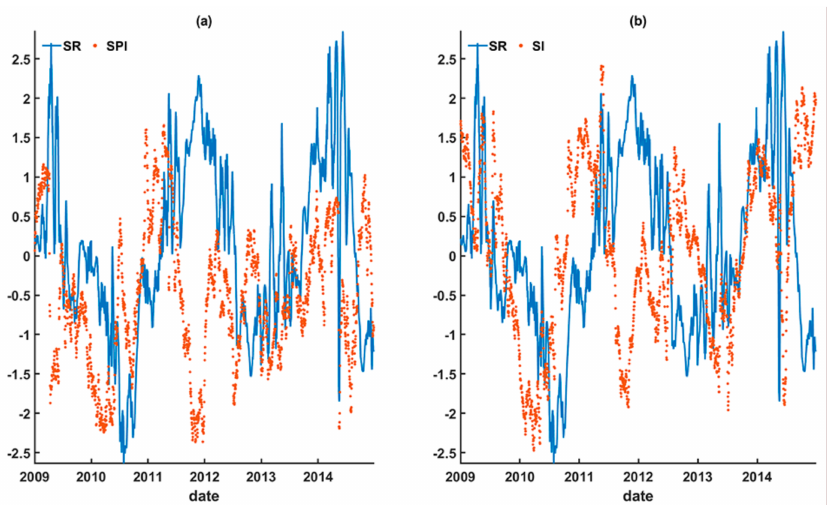
Figure 11. The time series of the upstream ( a ) SPI from TRMM and ( b ) SI from GRACE spatially averaged in Yunnan Province against the in situ runoff during